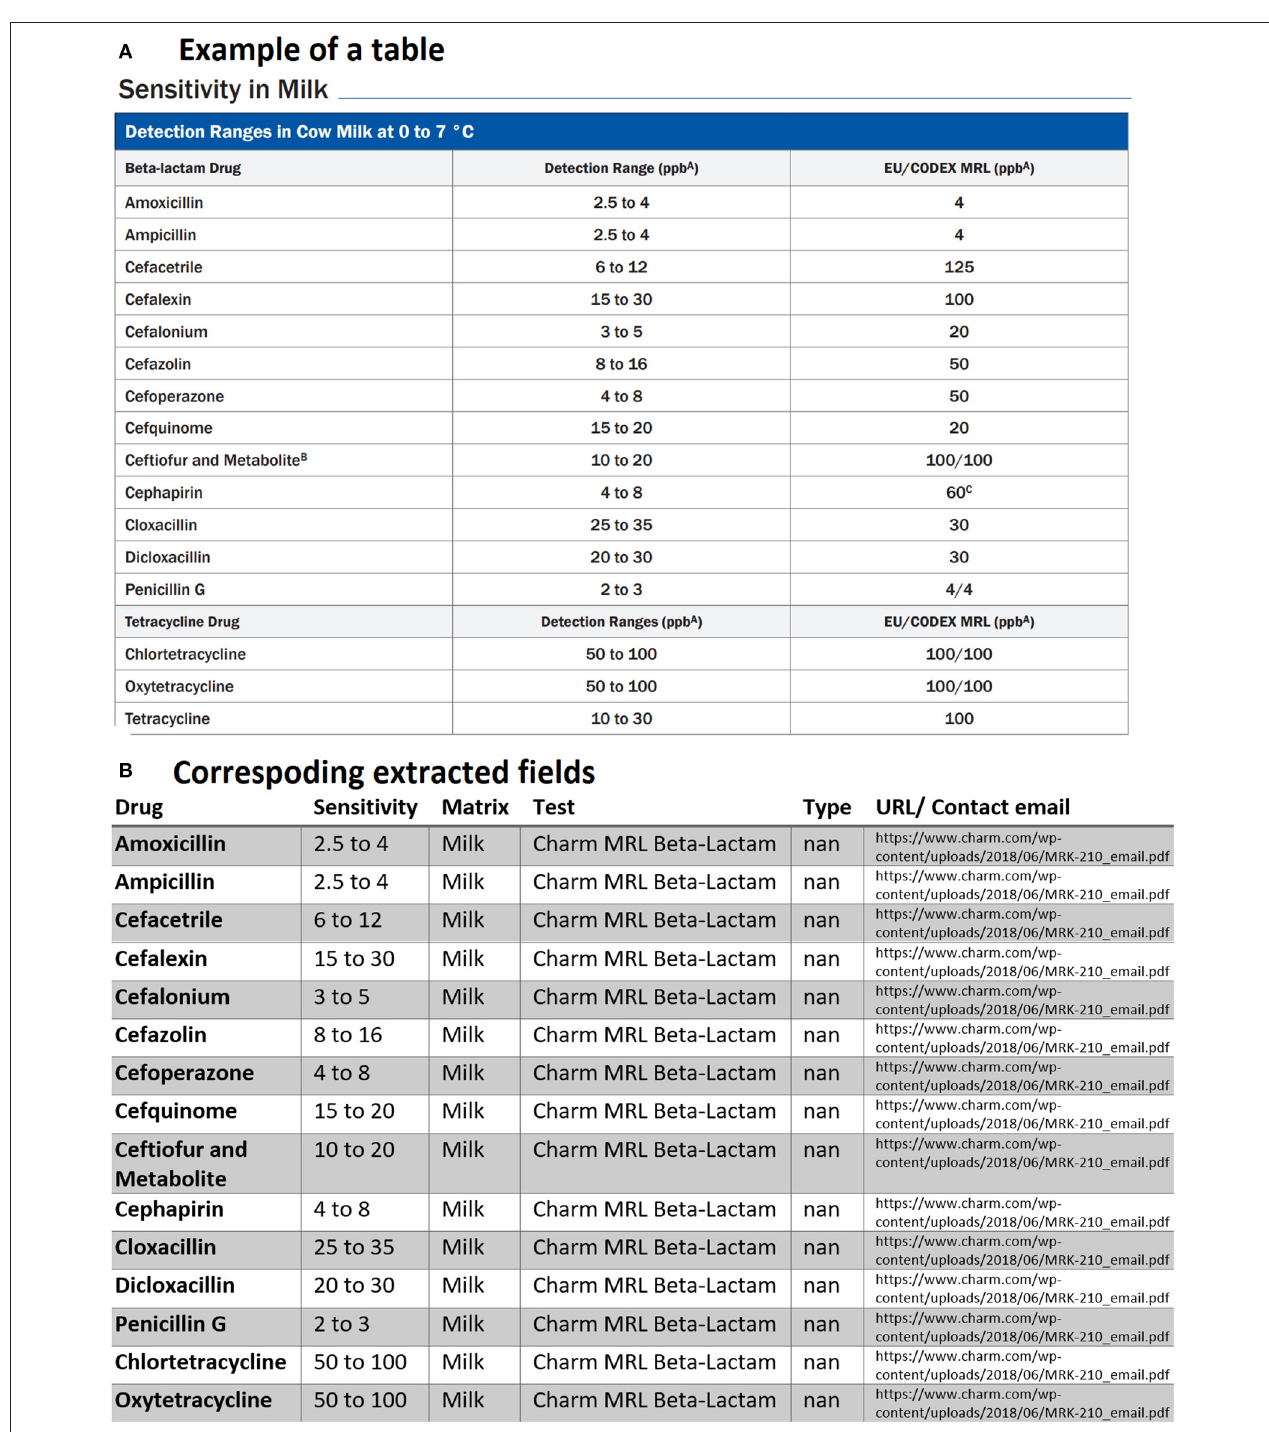
FIGURE 6 | An example of data table extraction for “Charm MRL Beta-Lactam” and the corresponding fields cleaned in a table where the last row for Tetracycline was not extracted initially from our data collection.